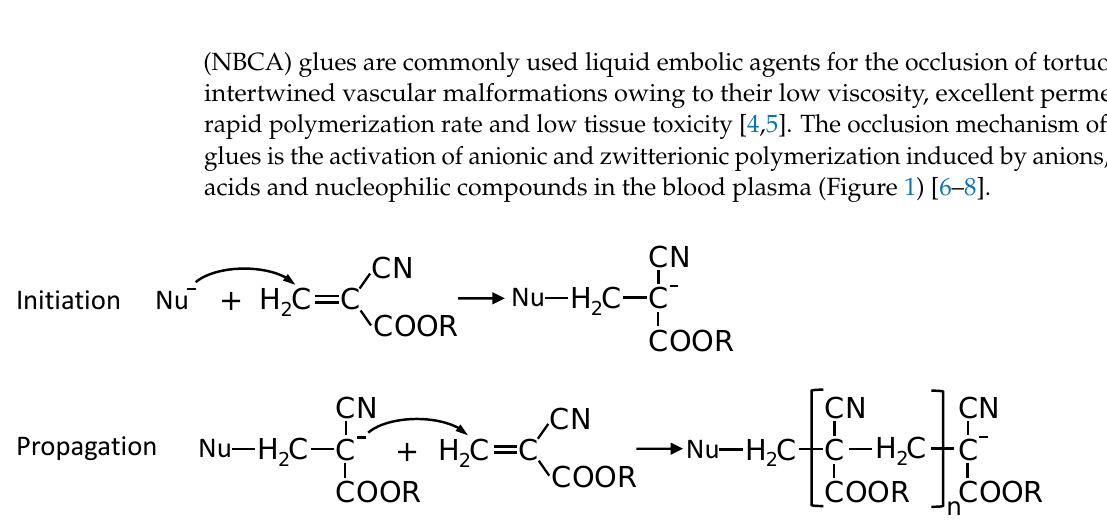
Figure 1. Initiation and propagation steps for alkyl (R) cyanoacrylate polymerization activated by nucleophile (Nu −